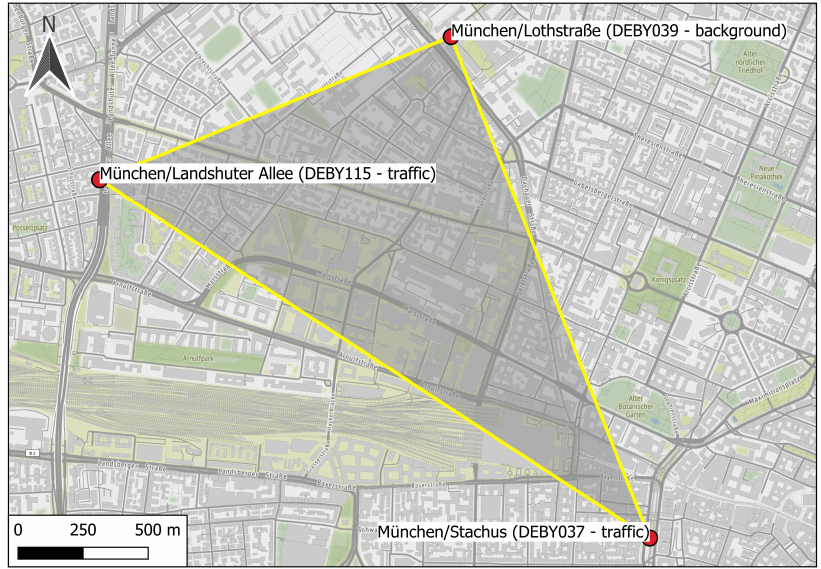
Figure 7. Triangle connecting three closely-located air quality measurement stations of different siting-types in the centre of Munich. Map tiles by Stamen Design under CC BY 3.0. Data by OpenStreetMap [47] under